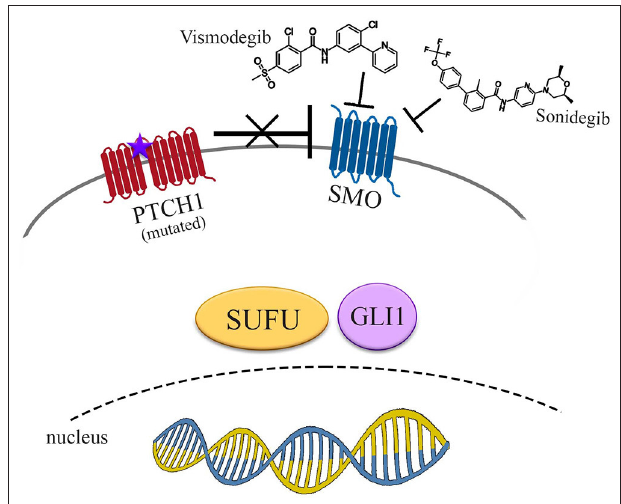
FIGURE 2 | Pharmacological inhibition of Hedgehog signaling pathway. Vismodegib and sonidegib act inhibiting SMO, even if derepressed by mutated PTCH1. No signals reach the nucleus to promote transcriptional activity of Hh target genes.